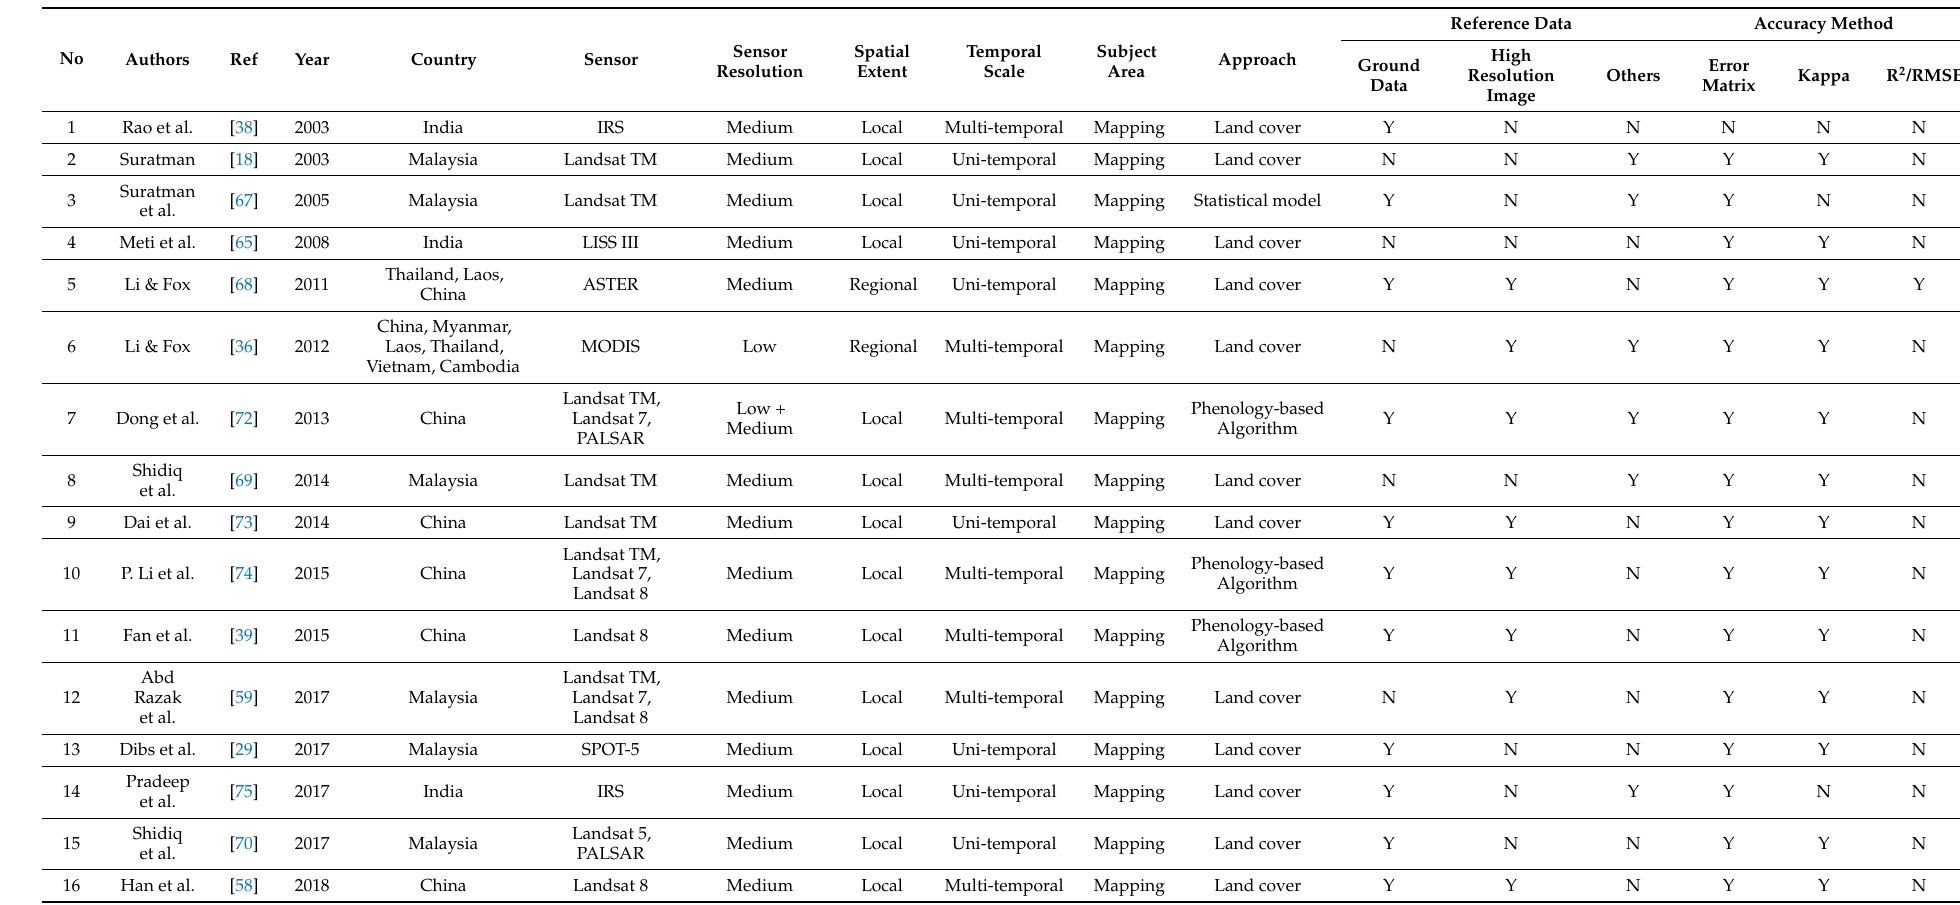
Table A1. A summary of the 74 studies assembled for this review. The attributes recorded include authors name, year, country of study area, sensor used, sensor resolution category, spatial extent, temporal scale, subject area, approach, reference data (ground data, high resolution image, and others) and accuracy method used (error matrix, kappa and R 2 /RMSE). [Note: Y = yes and N =